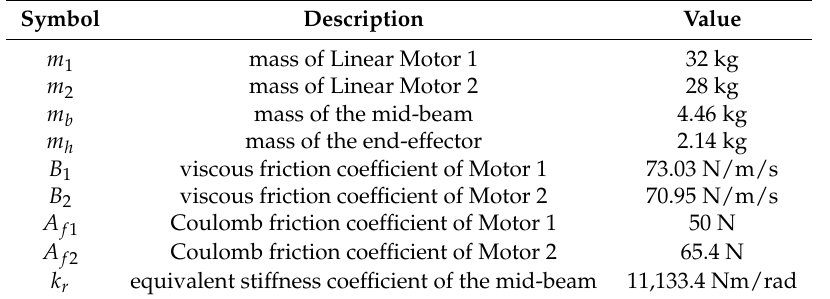
Table 2. Parameter values of the experimental